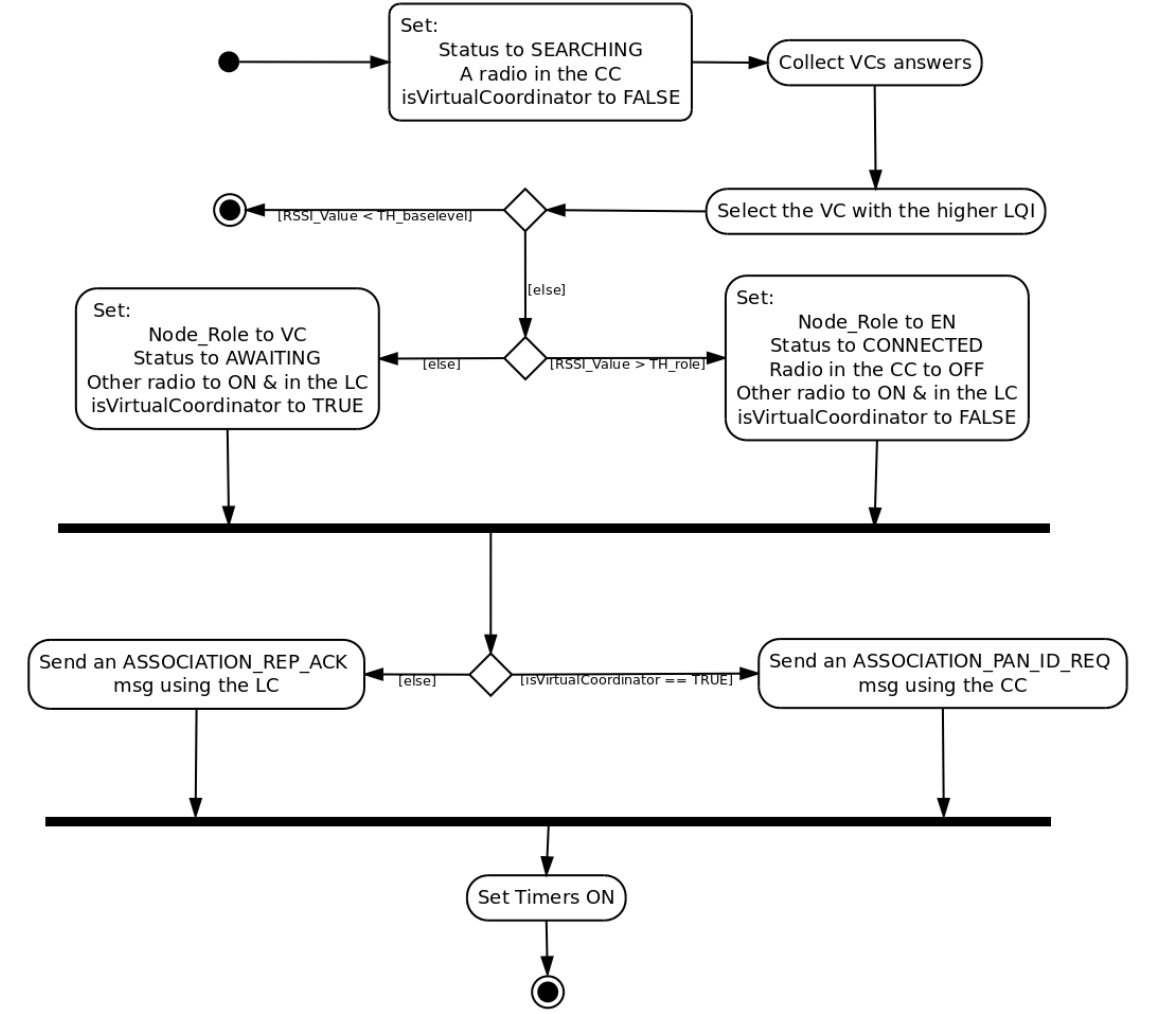
Figure 2. Dynamical Role Selection Process (DRSP) with multi-channel